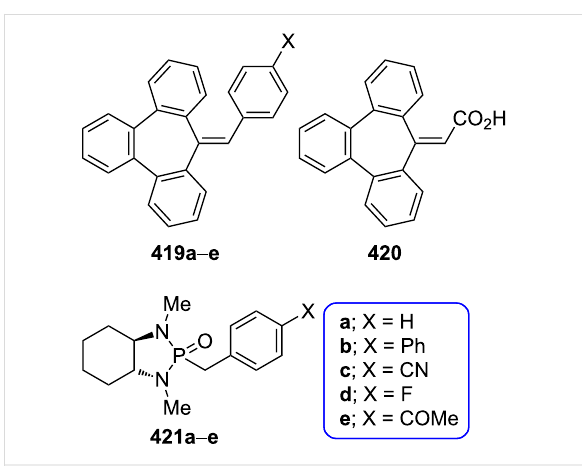
Figure 24: Structures of benzylidene- and methylene-9 H - tribenzo[ a , c , e ][7]annulenes 419 and 420 and chiral phosphonamides 421 .